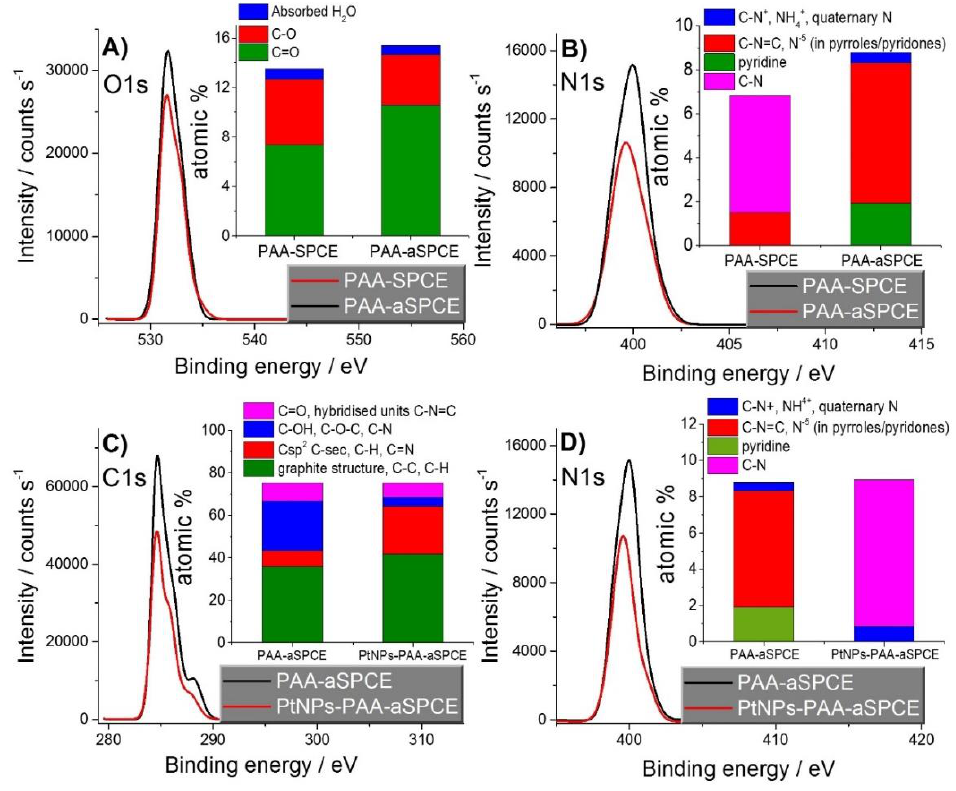
Figure 4. XPS ( A ) O1s and ( B ) N1s spectra for PAA-SPCE and PAA-aSPCE. XPS ( C ) C1s and ( D ) N1s spectra for PAA-aSPCE and PtNPs-PAA-aSPCE. The insets of the respective figures show the atomic surface concentrations of the functional groups after the deconvolution of the peaks.